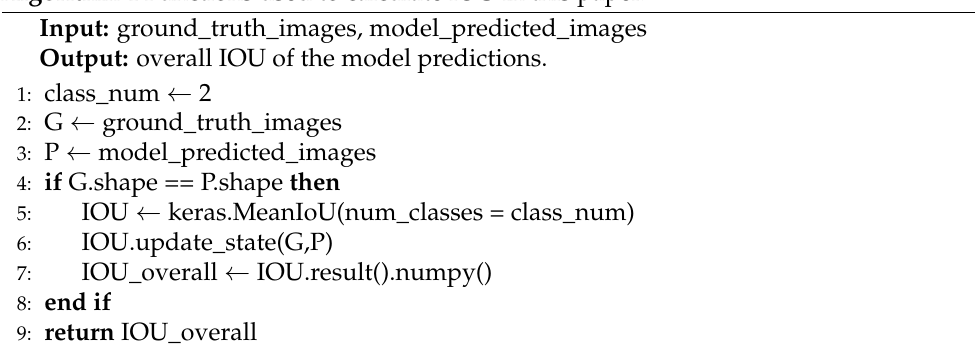
Algorithm 4 Functions used to calculate IOU in this